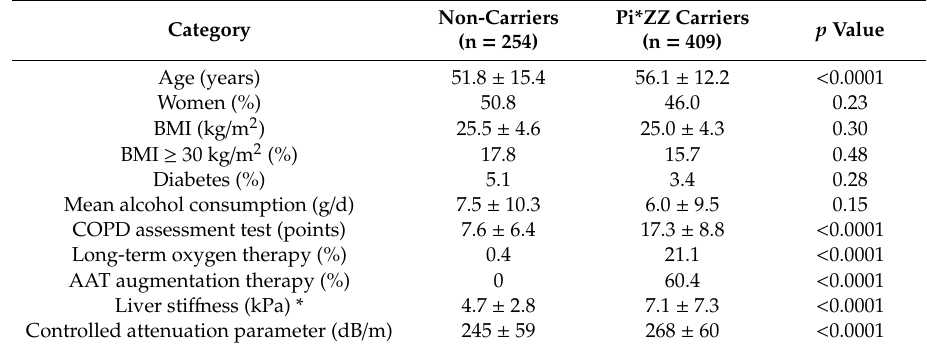
Table 1. Characteristics of individuals homozygous for the alpha-1 antitrypsin Pi*Z variant (Pi*ZZ) and subjects without Pi*Z carriage. Quantitative measures are expressed as mean ± standard deviation or as relative frequency (%).